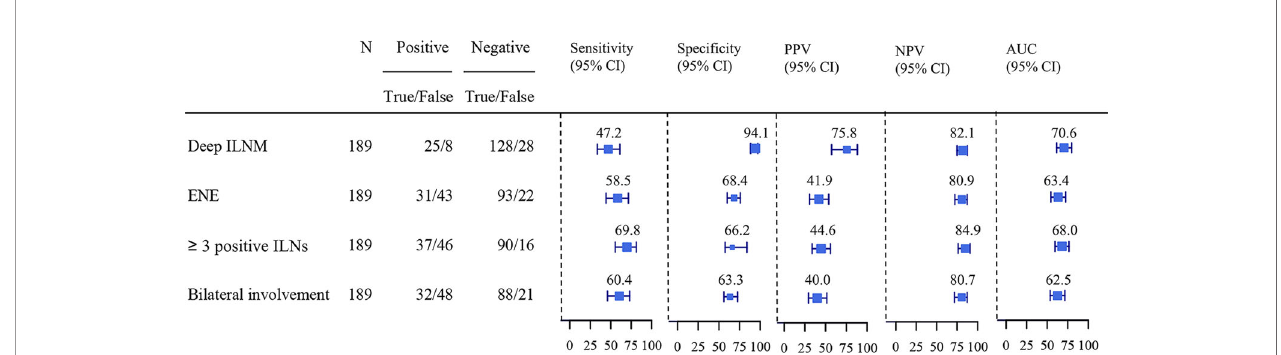
TABLE 3 | Univariable and multivariable Cox regression analyses of variables on CSS. Prognostic variables Univariable